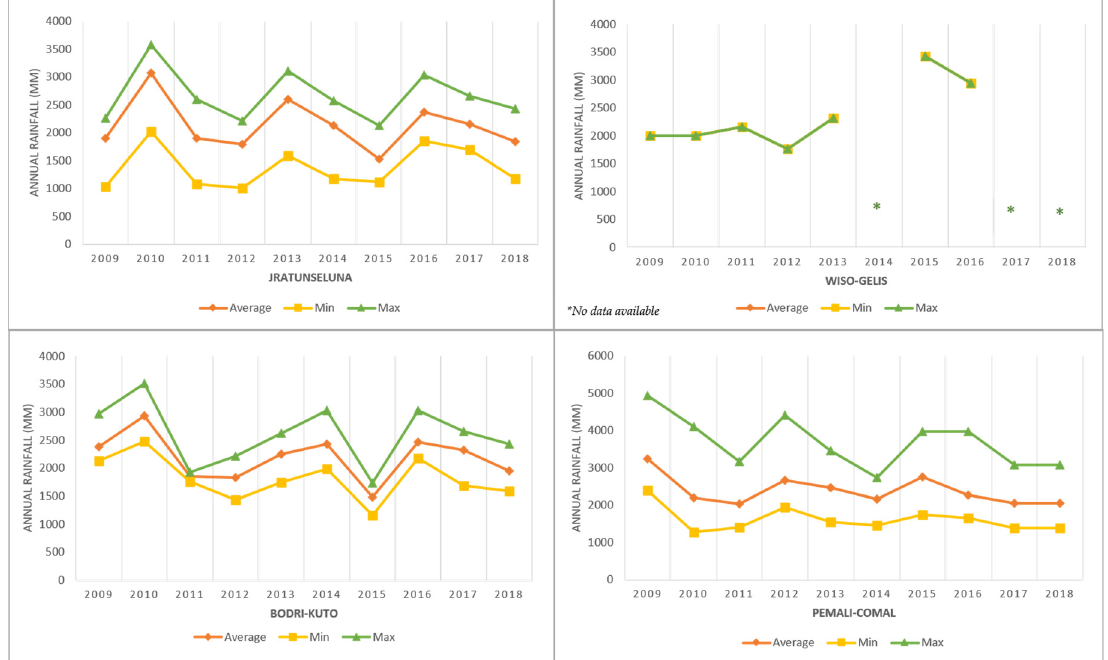
Figure 2. Rainfall in the Study Area in 2009–2018. Source: Meteorological, Climatological, and Geophysical Agency (MCGA) and Central Bureau of Statistics (CBS) 2009–2018. No data available for Wiso Gelis (2014, 2017, 2018). Rainfall data for Wiso-Gelis, Jatunseluna, Bodri-Kuto and Pemali-Comal are collected from 1, 9, 4, and 7 climatology stations, respectively.